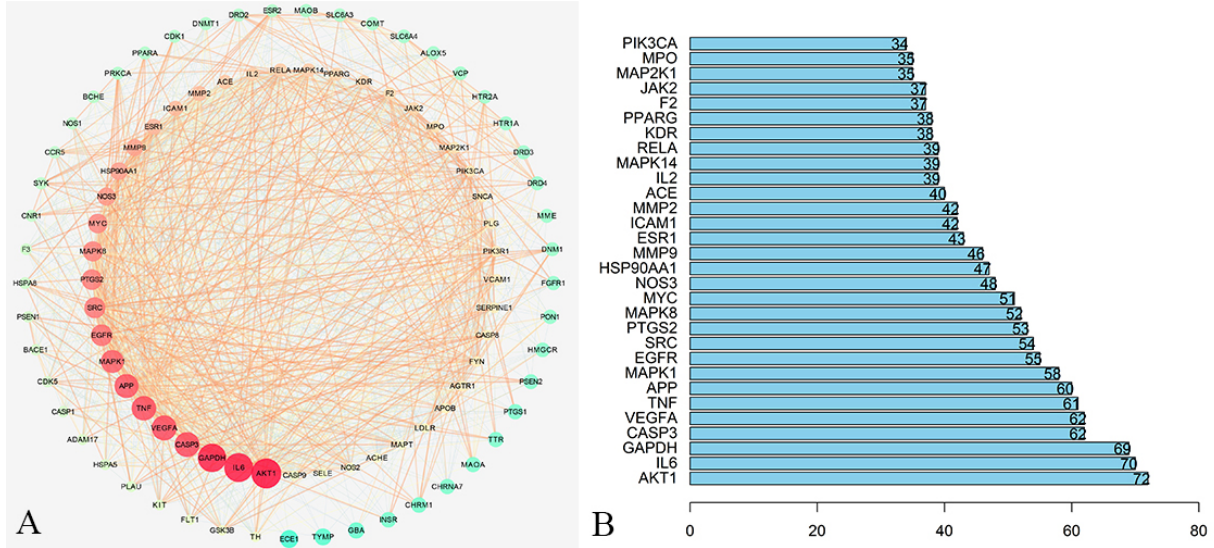
Fig. 1. The diagram of the core target of the protein interaction network. (A) The PPI visual network topology diagram of 95 common targets. The bigger the degree, the bigger the node, the darker the color, the more important the node. (B) The bar diagram of the top 30 core targets of the protein interaction network. On the left are the names of the genes. The number on the strip is the number of adjacent nodes of the corresponding gene.